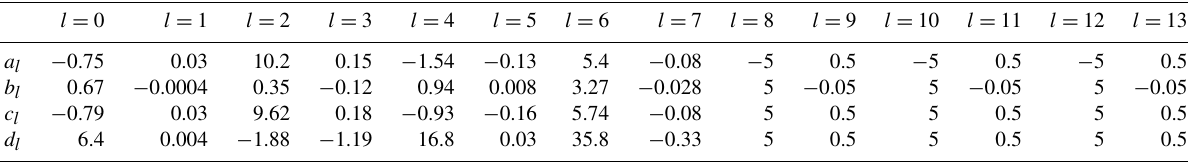
Table A1. Overview of the values for the coefficients a l , b l , c l and d l